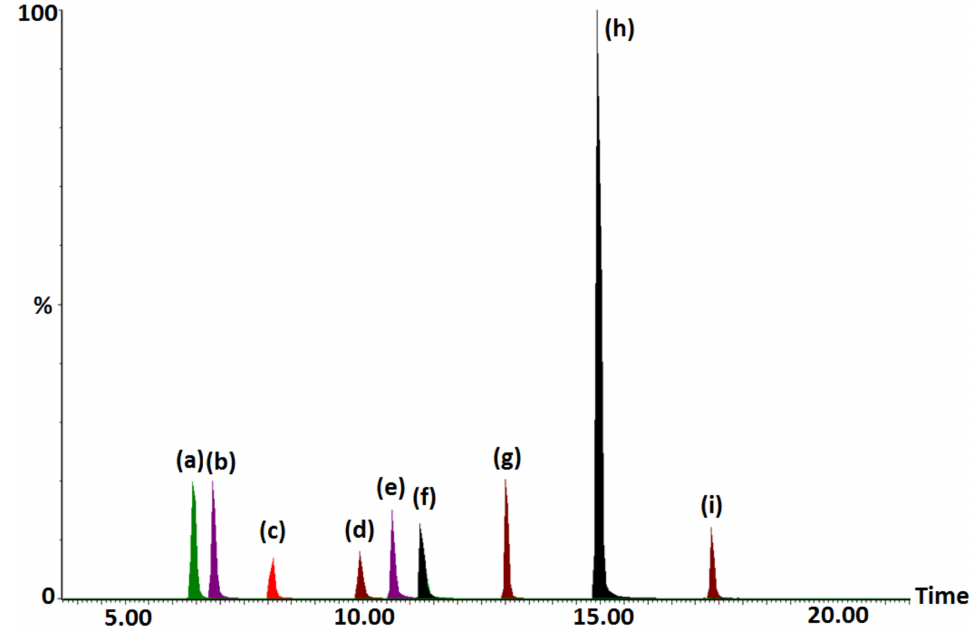
Figure 2. Chromatogram showing the separation of the selected pharmaceuticals using the optimized chromatographic conditions. ( a ) Acetaminophen, ( b ) Sulfadiazine, ( c ) Sulfapyridine, ( d ) Sulfamethazine, ( e )Ofloxacin, ( f )(Sulfamethoxazoleandciprofloxacin), ( g )Metoprolol, ( h )Resperidone, and( i